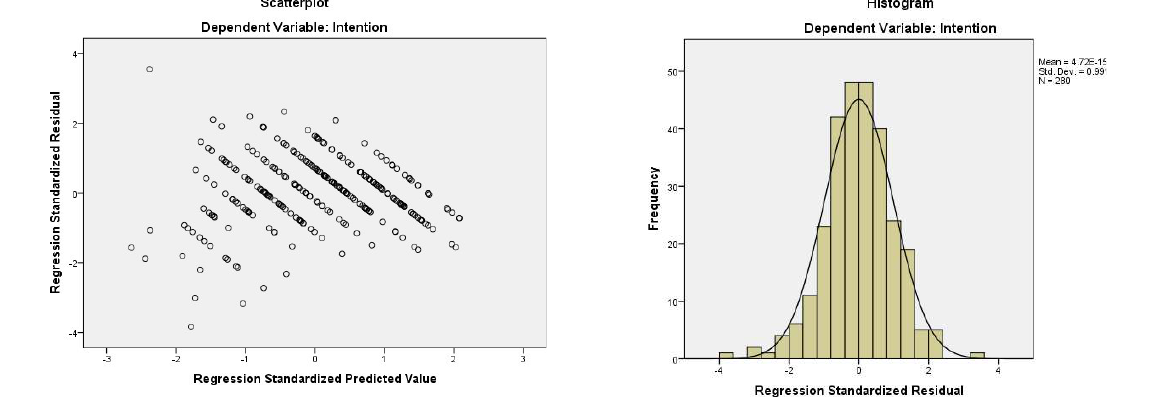
Fig. 3. Regression Standardized Predicted Value Fig. 4. Regression Standardized